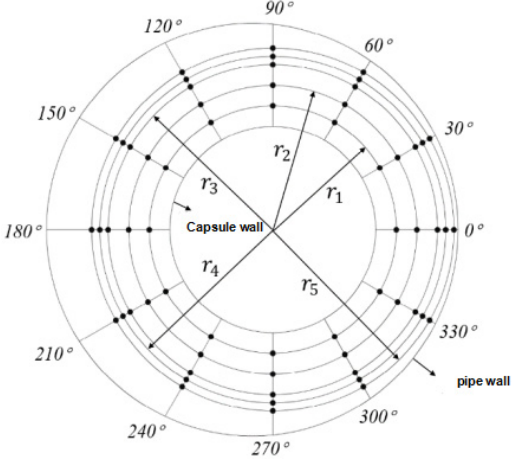
Figure 4. Schematic diagram of measuring point layout .